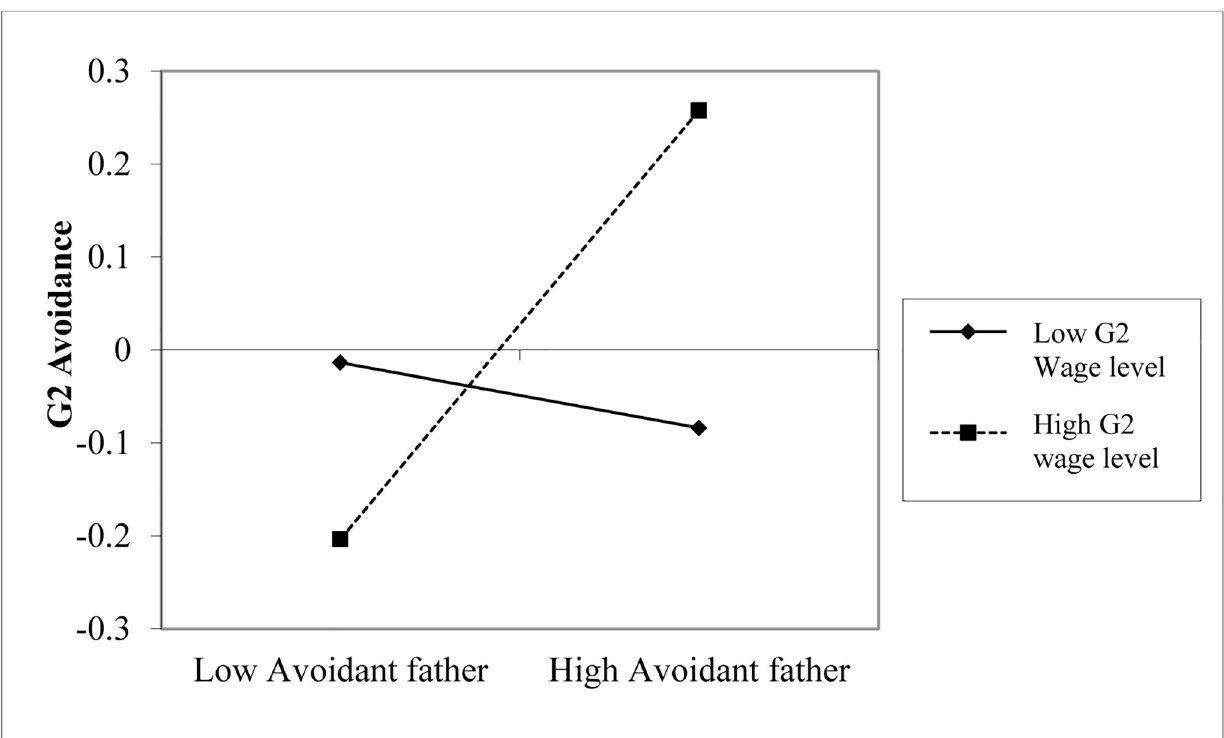
Fig 4. G1 fathers’ avoidance effects on G2 avoidance for low and high G2’s wage